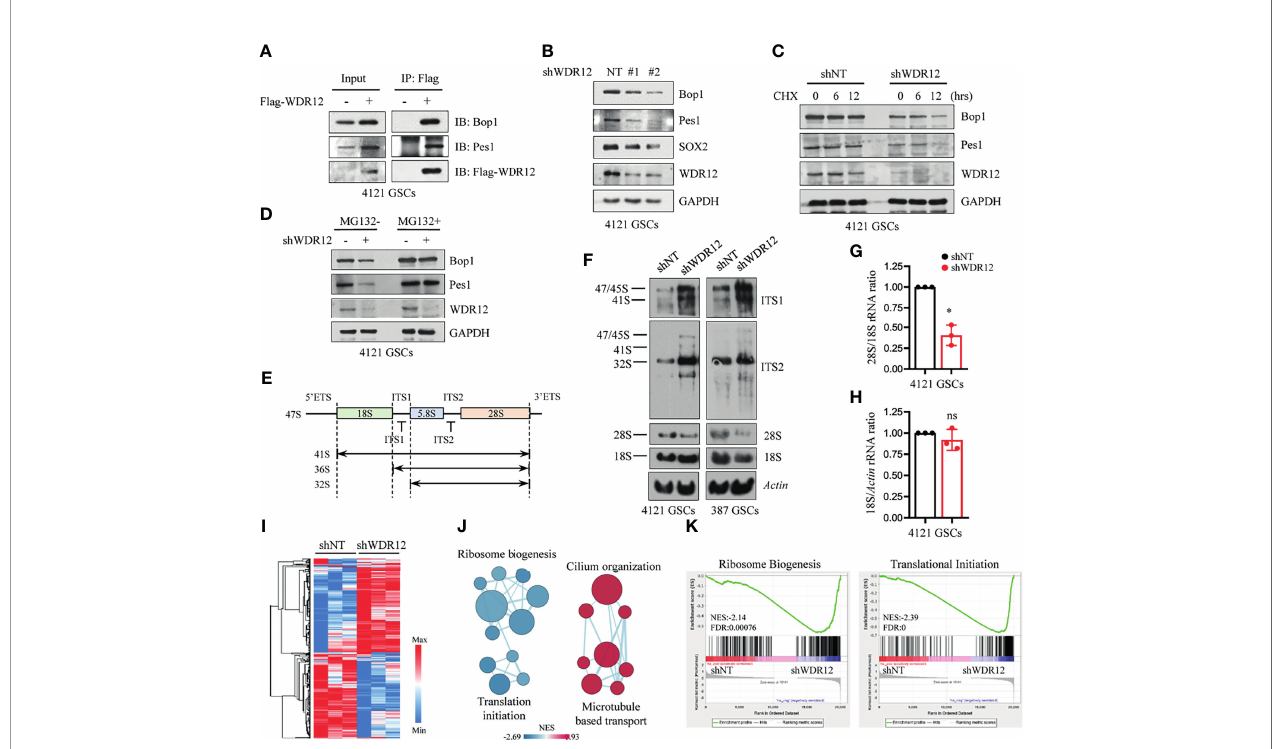
FIGURE 3 | WDR12 is required for GSC rRNA processing. (A) Co-immunoprecipitation (Co-IP) with anti-Flag beads in Flag-vector and Flag-WDR12 expressing GSCs and IB for WDR12, Pes1 and Bop1 are shown. (B) IB showing that knockdown of WDR12 decreased the protein levels of Pes1 and Bop1 in 4121 GSCs. (C) IB showing the CHX (50 m g/ml) chase analysis of Pes1 and Bop1 protein degradation at indicated time points in GSCs with or without WDR12 knockdown. (D) IB showing the levels of Pes1, Bop1 and WDR12 in shNT or shWDR12 transduced GSCs treated with vehicle control or MG132 (10 m M) for 12 hours. (E) Diagram of the primary 47S rRNA transcript and the major rRNA intermediates. Positions of the hybridization probes are depicted. ETS, external transcribed spacer; ITS, internal transcribed spacer. (F) Knockdown of WDR12 impairs formation of mature 28S rRNA. Northern blot analysis of total RNA extracted from GSCs after WDR12 knockdown. Biotin labeled probes binding to the ITS1, ITS2, 18S or 28S were used to detect the indicated rRNA precursors. Actin as loading control. (G, H) Ratio of 28S/18S rRNA (G) and 18S/Actin (H) in 4121 GSCs transduced with shNT or shWDR12. Quanti fi cation of three independent experiments as shown. Data are represented as mean ± SD. *p < 0.05, as assayed by Welch ’ s t test. (I – K) RNA-seq analysis in 4121 GSCs transduced with shNT or shWDR12 for 24 hours. Heatmap showing relative expression levels of genes down- or up-regulated in shWDR12-GSCs compared with the shNT-GSCs. A relative color scheme used the minimum and maximum values in each row to convert values to colors (I) . Pathway enrichment analysis using GSEA (K) , and visualization using Cytoscape Enrichment Map (J) in GSCs with WDR12 knocked down are shown. Red nodes represent upregulated pathways and blue nodes represent downregulated pathways in WDR12 knocked down GSCs compared to control GSCs (FDR < 0.05). ns, no